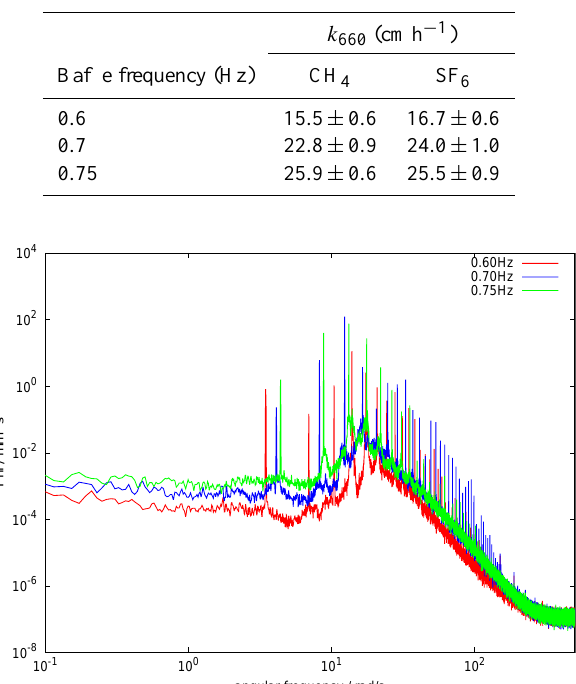
Table 1. Estimated values of k 660 derived from CH 4 and SF 6 for six different Milli-Q experiments.